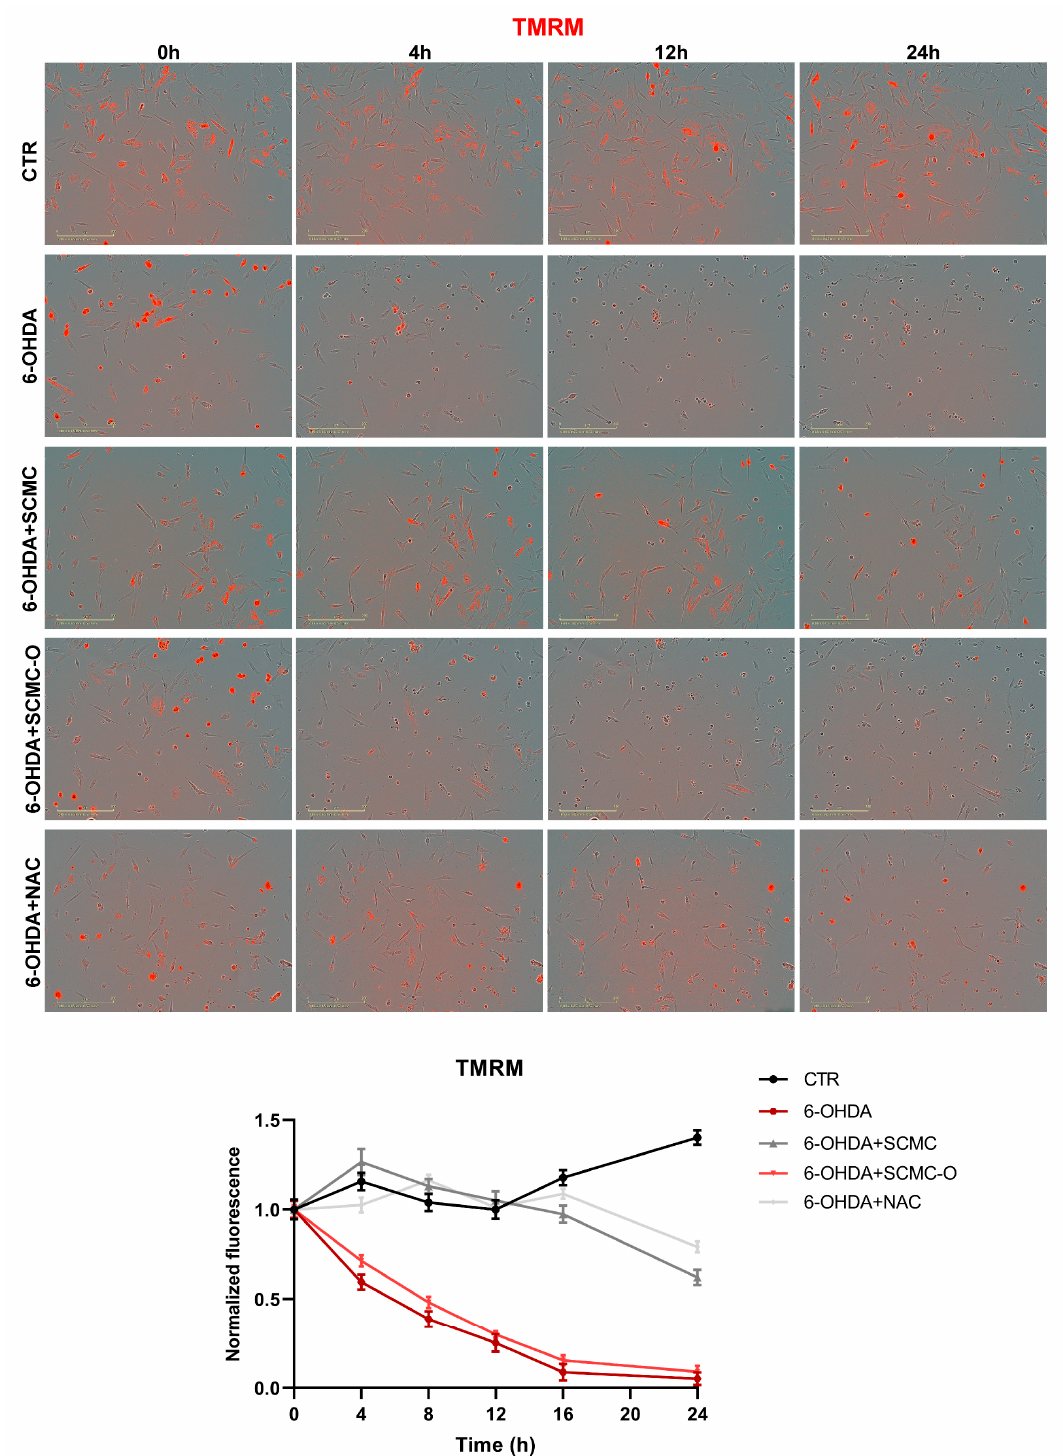
Figure 8. TMRM in live-cell by Incucyte system at 0 h, 4 h, 12 h, and 24 h time points. Representative images and relative normalized fluorescence graph are shown. Data are mean of three different experiments ± SD. The significance is reported in Table S1. Scale bar: 200 μ m.